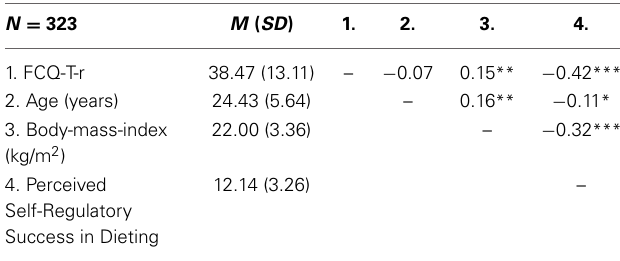
FCQ-T-r, Food Cravings